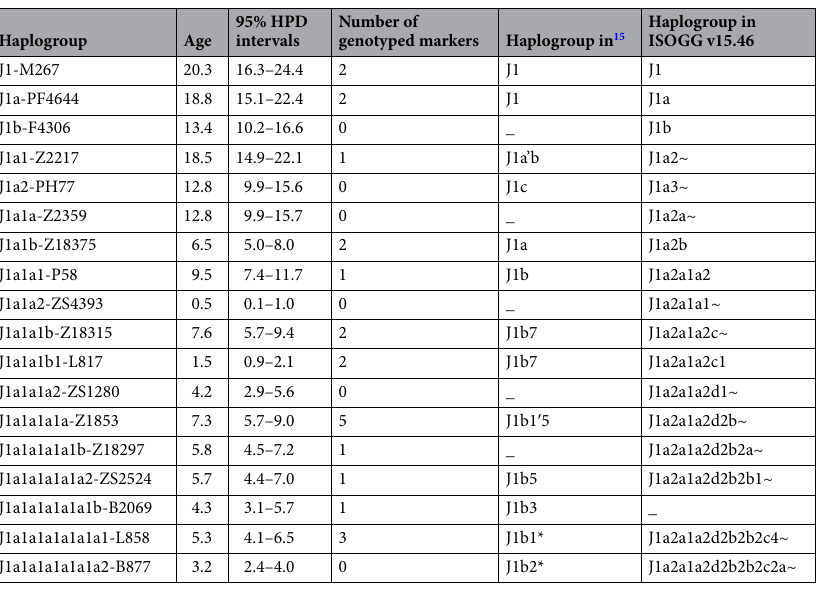
Table 1. Age estimates of haplogroup J1-M267 and its branches. Coalescence times and 95% HPD intervals were estimated with Beast v1.10.4 82 and are expressed in thousand years ago. For comparison purposes, the branch names in other Y chromosome trees are provided also. Only the branches discussed in the main text are listed. Underscore means the branch is missing. *The branch names were later updated 29